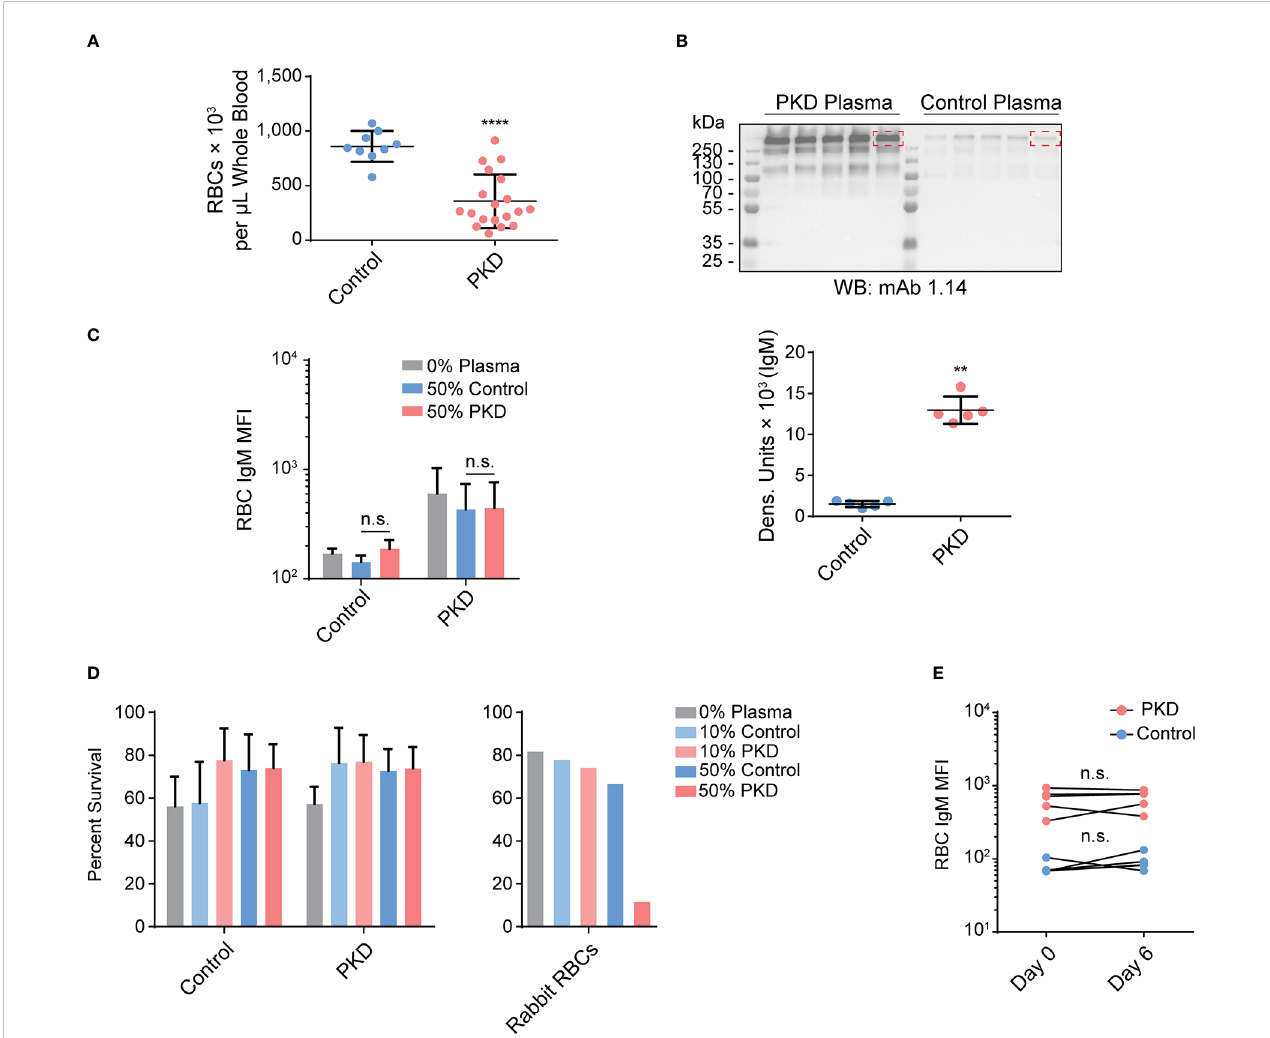
FIGURE 3 Despite anemia and IgM hypergammaglobulinemia in infected fi sh with proliferative kidney disorder (PKD), the IgM from fi sh with PKD is neither autoreactive nor hemolytic. (A) Via fl ow cytometry, we quanti fi ed the number of red blood cells (RBCs) per m L of whole blood and determined that fi sh with PKD were anemic. We plotted mean +/- SD of the number of RBCs per m L of whole blood. The difference between the control and PKD groups was determined to be signi fi cant by the Mann-Whitney U test; n = 9 for control fi sh and n = 19 for the PKD cohort. (B) mAb 1.14 immunoblotting on plasma (diluted to 3.75%) from randomly selected fi sh in both the PKD and control groups. We performed densitometry using the dominant IgM band (indicated by dashed red rectangles) that was visible in both groups. The Mann-Whitney U test determined that the amount of circulating IgM was signi fi cantly higher in the plasma of PKD fi sh. RBCs from individuals in control or PKD groups (n = 5, in each group) were incubated in 10% or 50% plasma pooled from either control fi sh or from PKD fi sh. We measured surface IgM levels (C) and percent surviving propidium iodide-negative cells (D) among RBCs after 20 hours of culture. Any changes in either parameter were calculated using a two-way repeated measures ANOVA. A post hoc Tukey ’ s multiple comparisons test revealed that there were no signi fi cant differences in surface IgM levels nor cell viability between cells treated with identical concentrations of pooled experimental plasma from PKD and control animals. However, when we used rabbit RBCs as target cells instead, the 50% PKD rainbow trout plasma was potent and lysed nearly all RBCs unlike the control plasma. (E) To further support that IgM on the surfaces of RBCs are not bound to cognate RBC antigens, the phenotype was monitored after six days of in vitro culture. Just like RBCs from control fi sh, the levels of surface IgM were unchanged after six days of culture as determined by a two-way repeated measures ANOVA with Sidak ’ s multiple comparisons test. This stability is not characteristic of typical antigen-antibody complexes in live, non- fi xed cells. n.s. P > 0.05; **P < 0.01; and ****P <